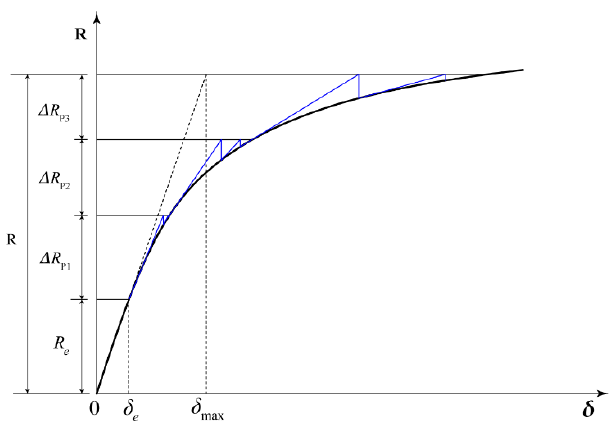
Figure 1. Elastic-plastic load release